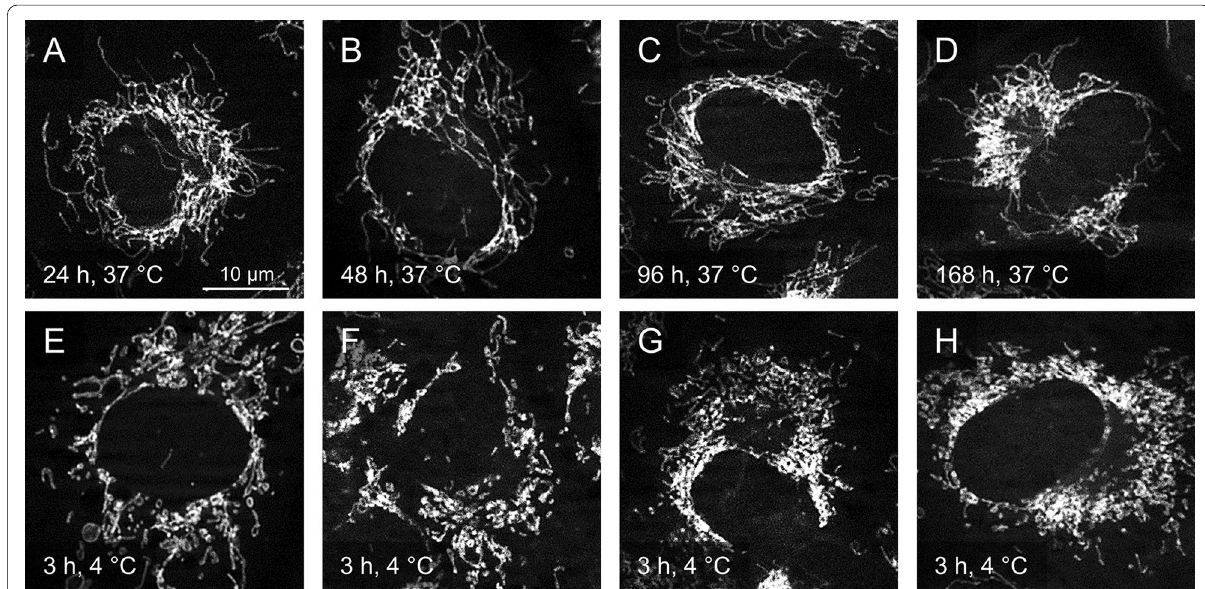
Fig. 5 Growth dependence of cold-induced mitochondrial fission. Porcine aortic endothelial cells were cultured before cold incubation for 24 h, 48 h, 96 h and 168 h at 37 °C ( A – D ). Thereafter, the cells were incubated for 3 h at 4 °C ( E – H ). MitoTracker Red-stained mitochondria were documented by fluorescence microscopy (λ exc.